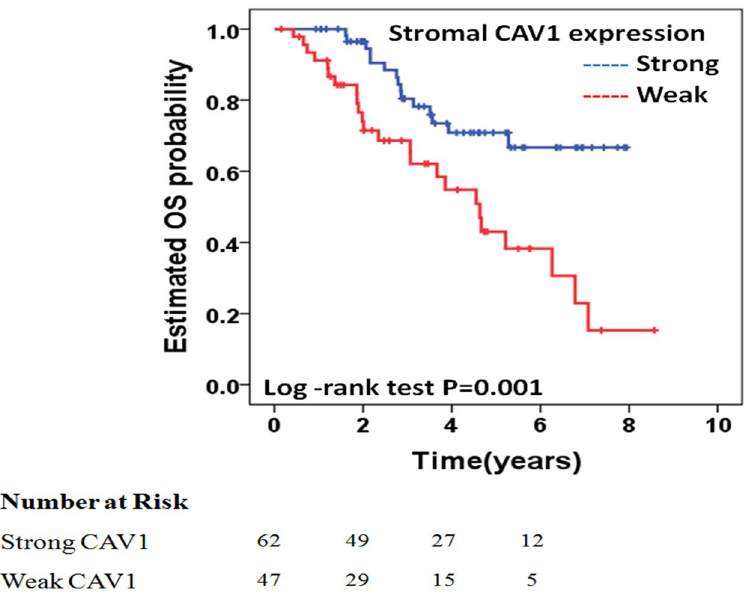
Figure 3. Kaplan–Meier analysis. Stromal CAV1 expression and overall survival. Weak stromal CAV1 expression is associated with a decreased